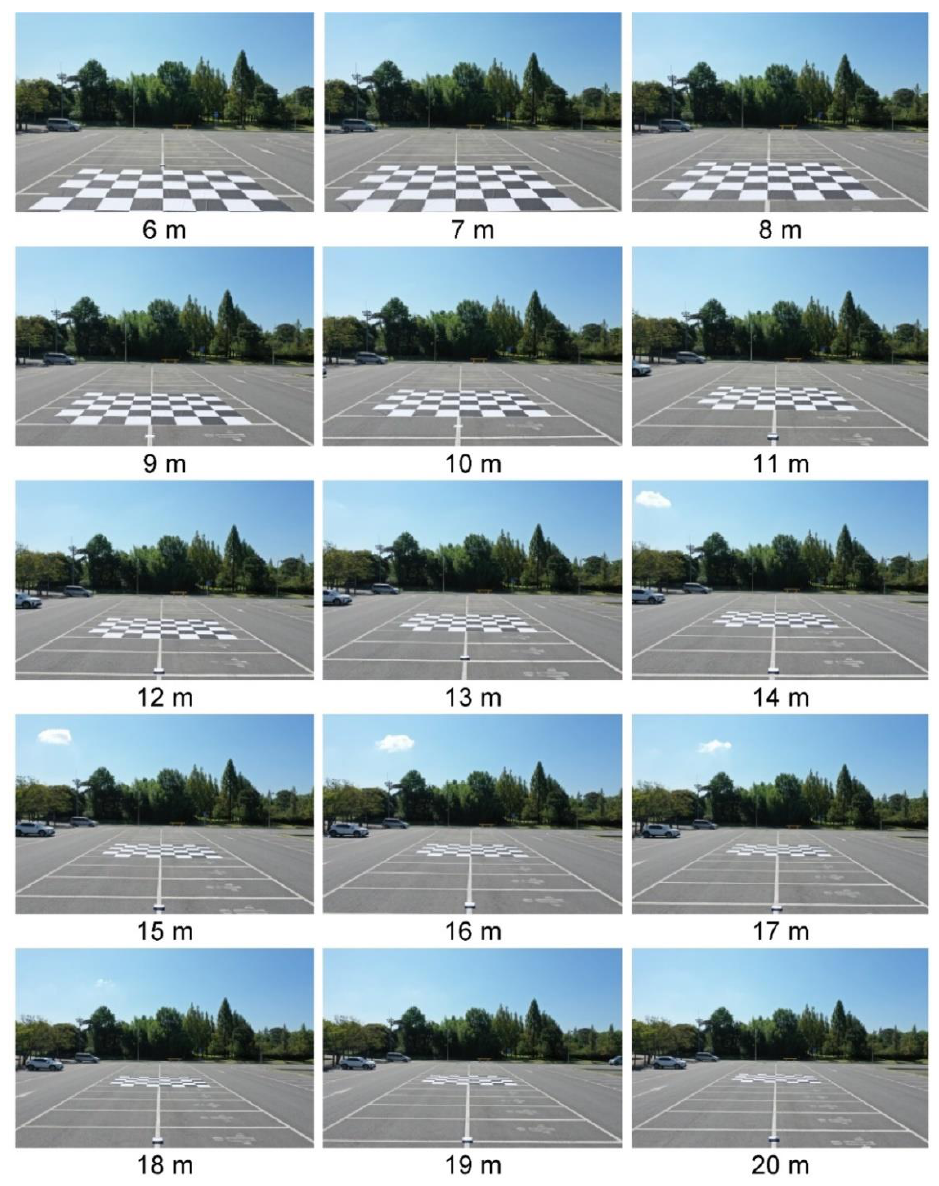
Figure 17. The images taken for camera calibration. A region calibrated with respect to the central axis of the camera was obtained via rotation transforming the calibration area by a distorted angle with respect to the central axis